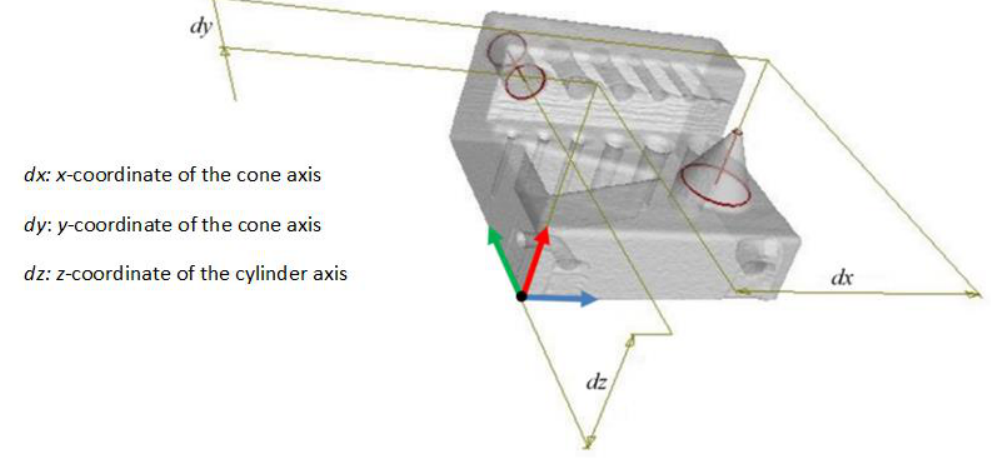
Figure 6. Measurands on test plate.